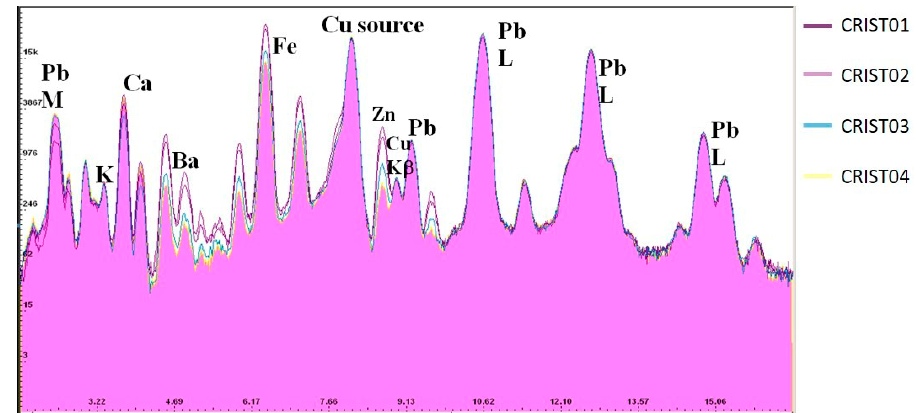
Figure 7. XRF spectrum of samples Crist01-Crist04, from the upper layer to the cleanest zone (Crist04). Pb has maximum concentration in the cleanest layer; conversely, Ba, Mn, Fe and Zn have minimum concentration in the cleaned layer.